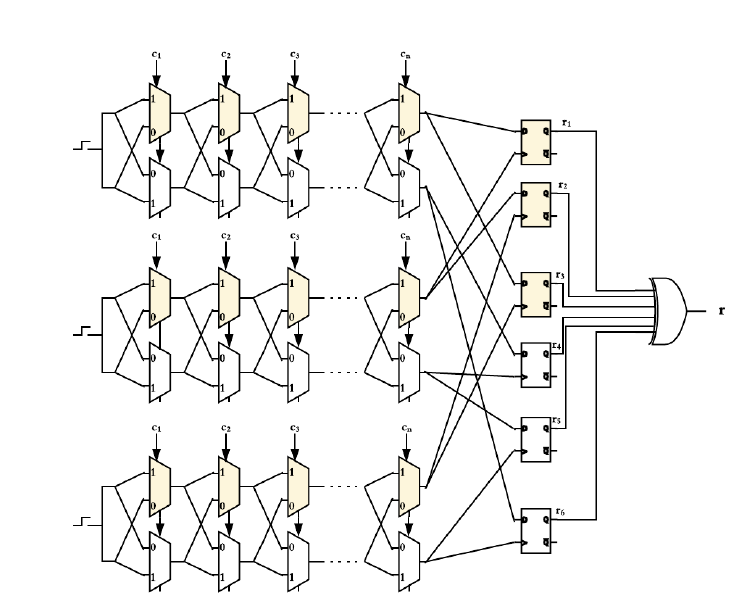
Figure 5. Structure of 3-1 Double Arbiter